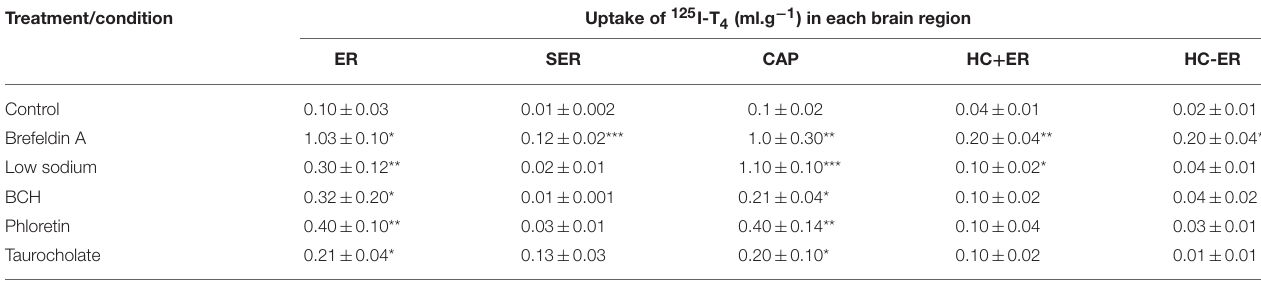
TABLE 2 | Effects of various drug treatments on the uptake of 125 I-T 4 (ml.g − 1 ) in various brain tissues of